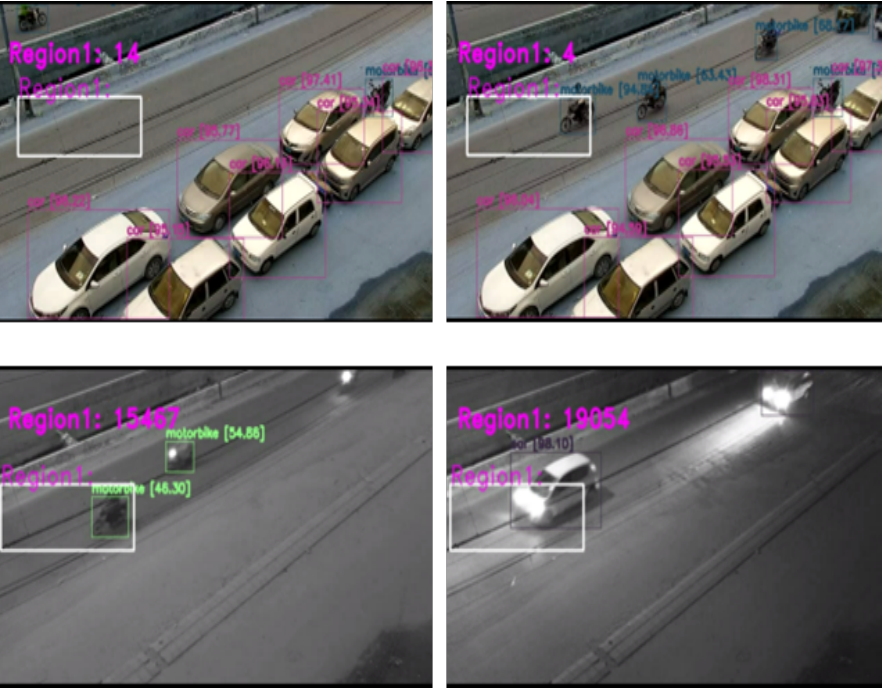
Figure 8. Classification of vehicles. After training, NVIDIA Jetson Nano is used for detection, identification and tracking of road vehicles in a video stream using the YOLOv5 algorithm. The main focus was to locate vehicles in live video frames. Figure 9 shows the detection of vehicles in a night video stream. Despite poor lighting and night video, YOLOv5 was able to identify and track the vehicle.